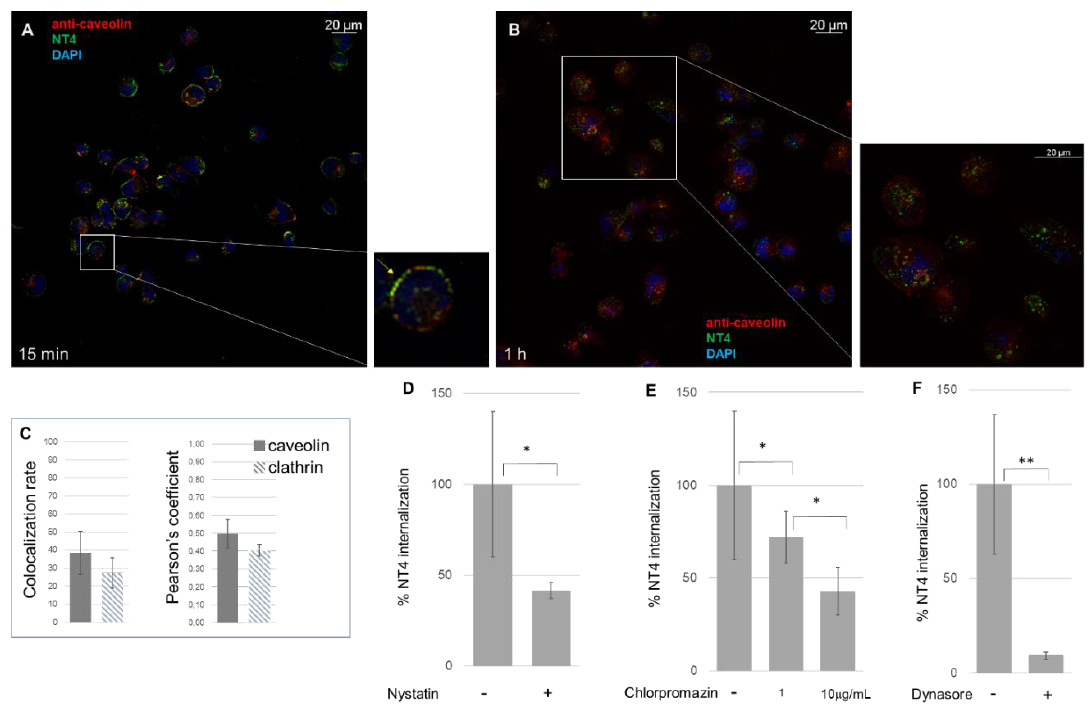
Figure 2. The process of NT4 endocytosis is caveolin-mediated. Colocalization of NT4 with caveolin after ( A ) 15 min, the yellow arrow in the zoomed area shows colocalization, and ( B ) 1 h incubation; ( C ) colocalization rate of NT4 and anti-caveolin ( n = 12) and anti-clathrin antibodies ( n = 9), after 30 min incubation, measured as colocalization rate and Pearson coe ffi cient. ( D ) Inhibition of NT4 internalization by nystatin (* p = 0.0345, n = 9), ( E ) by chlorpromazine 1 µ g / mL (* p = 0.0279, n = 3) and 10 µ g / mL (* p = 0.0327, n = 4) and ( F ) by dynasore (** p = 0.0043, n = 6).